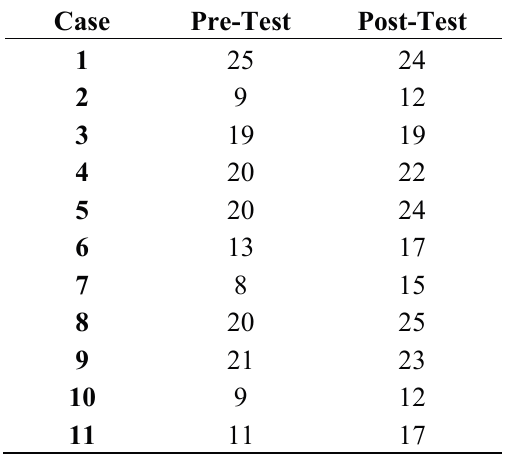
Table 3. Scores of shoulder-related actions in WMFT for stroke